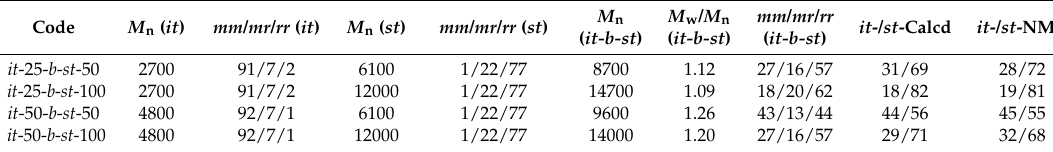
Table 1. Molecular weight and tacticity of prepolymers and it - b - st PMMAs.